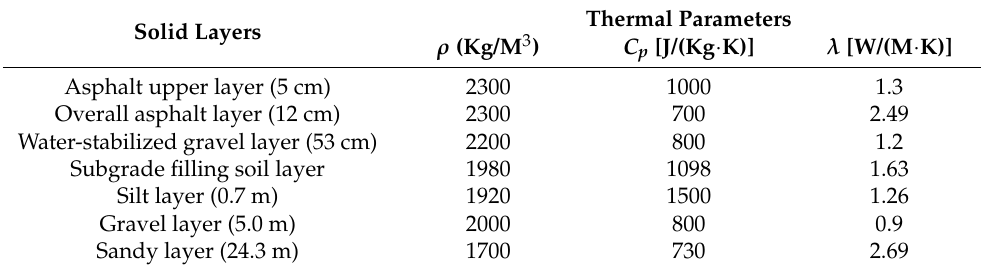
Table 4. Thermophysical parameters of solid